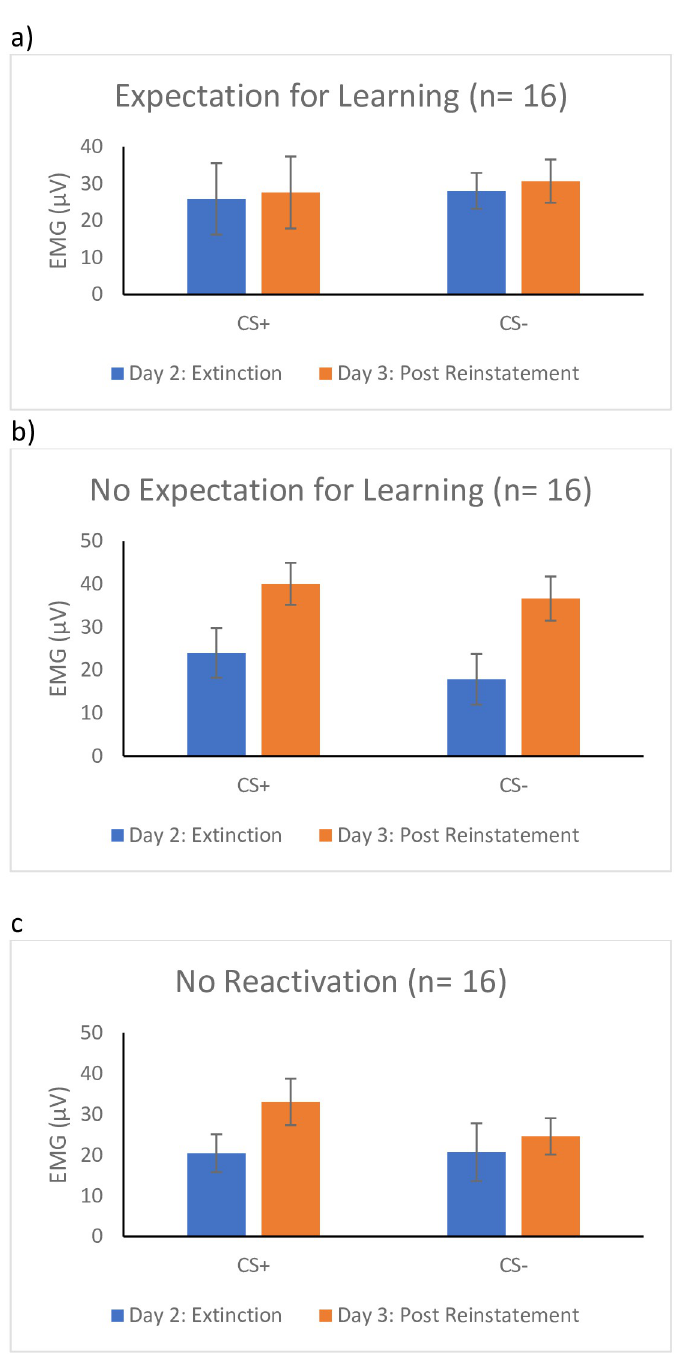
Fig 5. Return of fear following reinstatement as measured by FPS for the a) Expectation for learning group, b) the no Expectation for learning group, and c) the No reactivation group. Note . Results for fear potentiated startle (FPS). Day 2 is a measure of fear following extinction (i.e., last trial of extinction). Day 3 is a measure of fear following reinstatement of fear (i.e., first trial of re-extinction). The error bars represent standard error. Measures of FPS were taken at every presentation of a